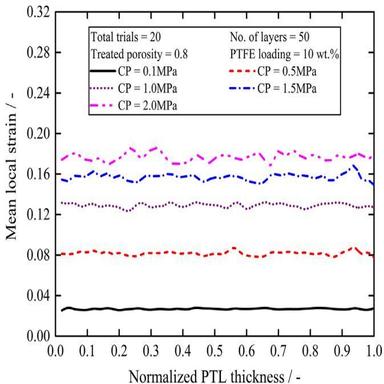
Statistical-mean local strain along the normalized PTLs thickness as a function of the external clamping pressure.